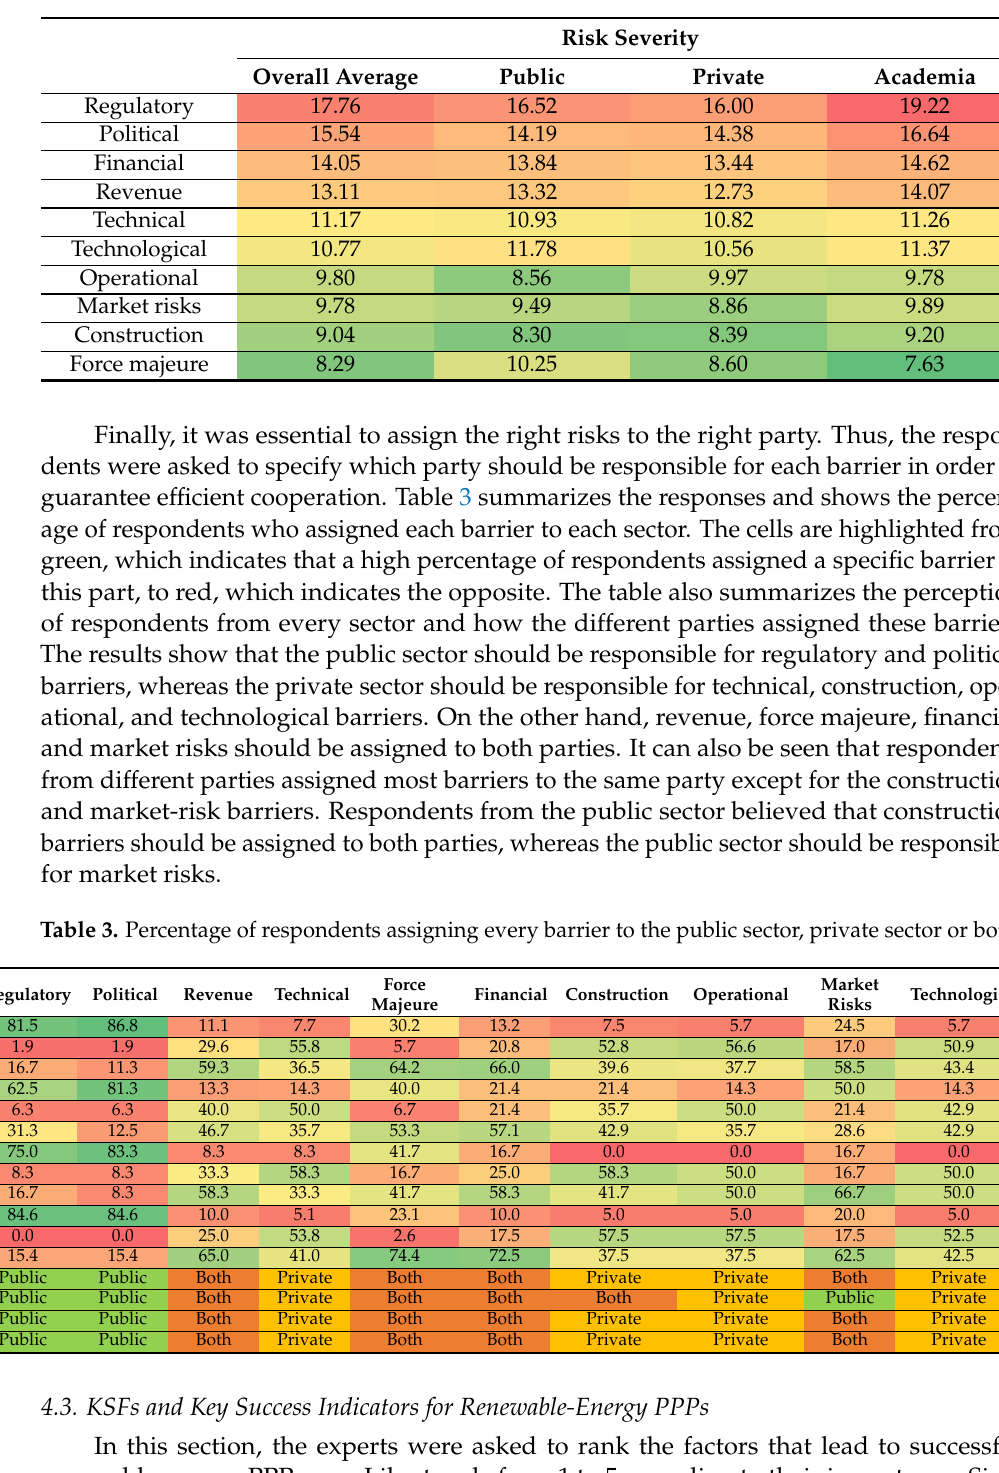
Table 2. Risk severity for every barrier.